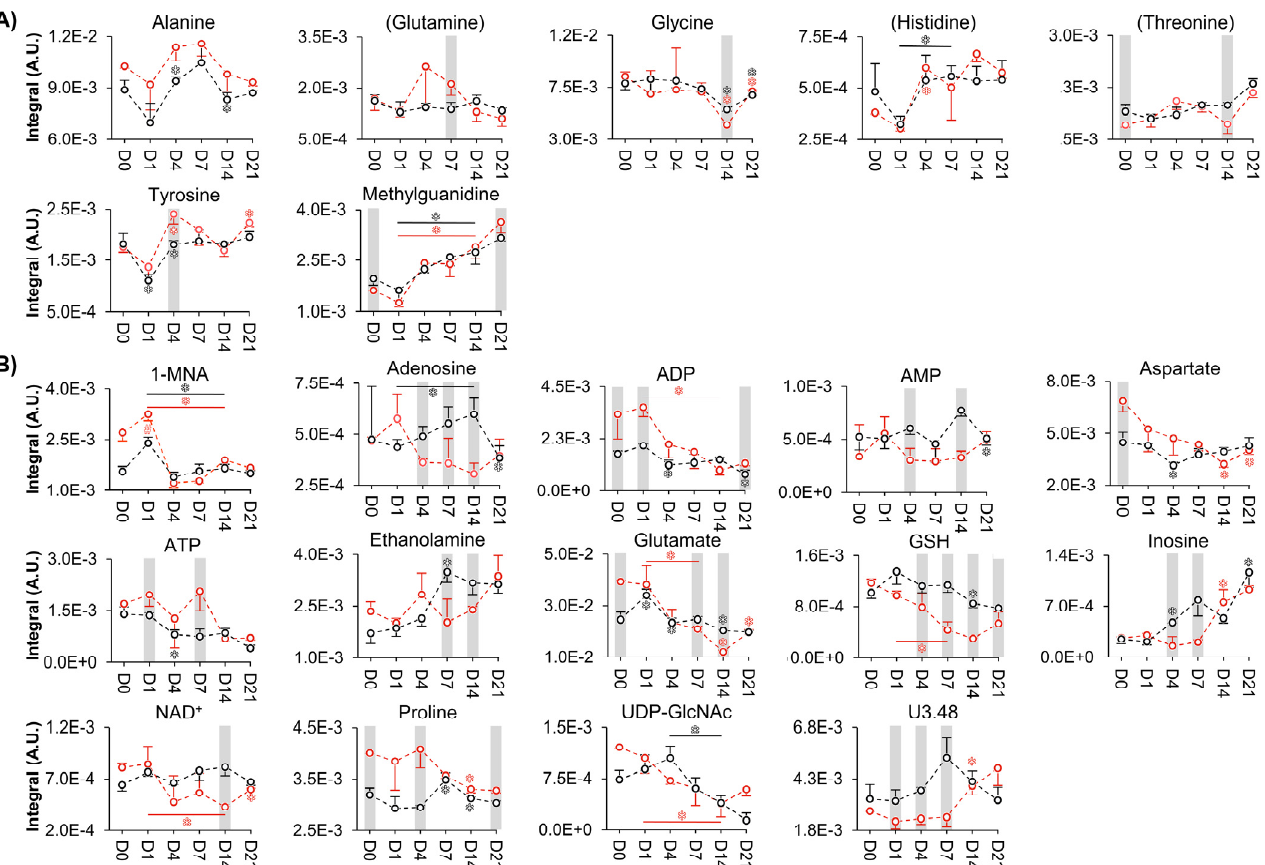
Figure 4. Metabolic ratios as donor-independent markers specific to hAMSCs osteodifferentiation (solid lines) in comparison with their control counterparts (dashed lines); ( A ) Cr/PCr, ( B ) Cho/PCho and ( C ) Etn/PCho for donors 1 (in black) and 2 (in red).